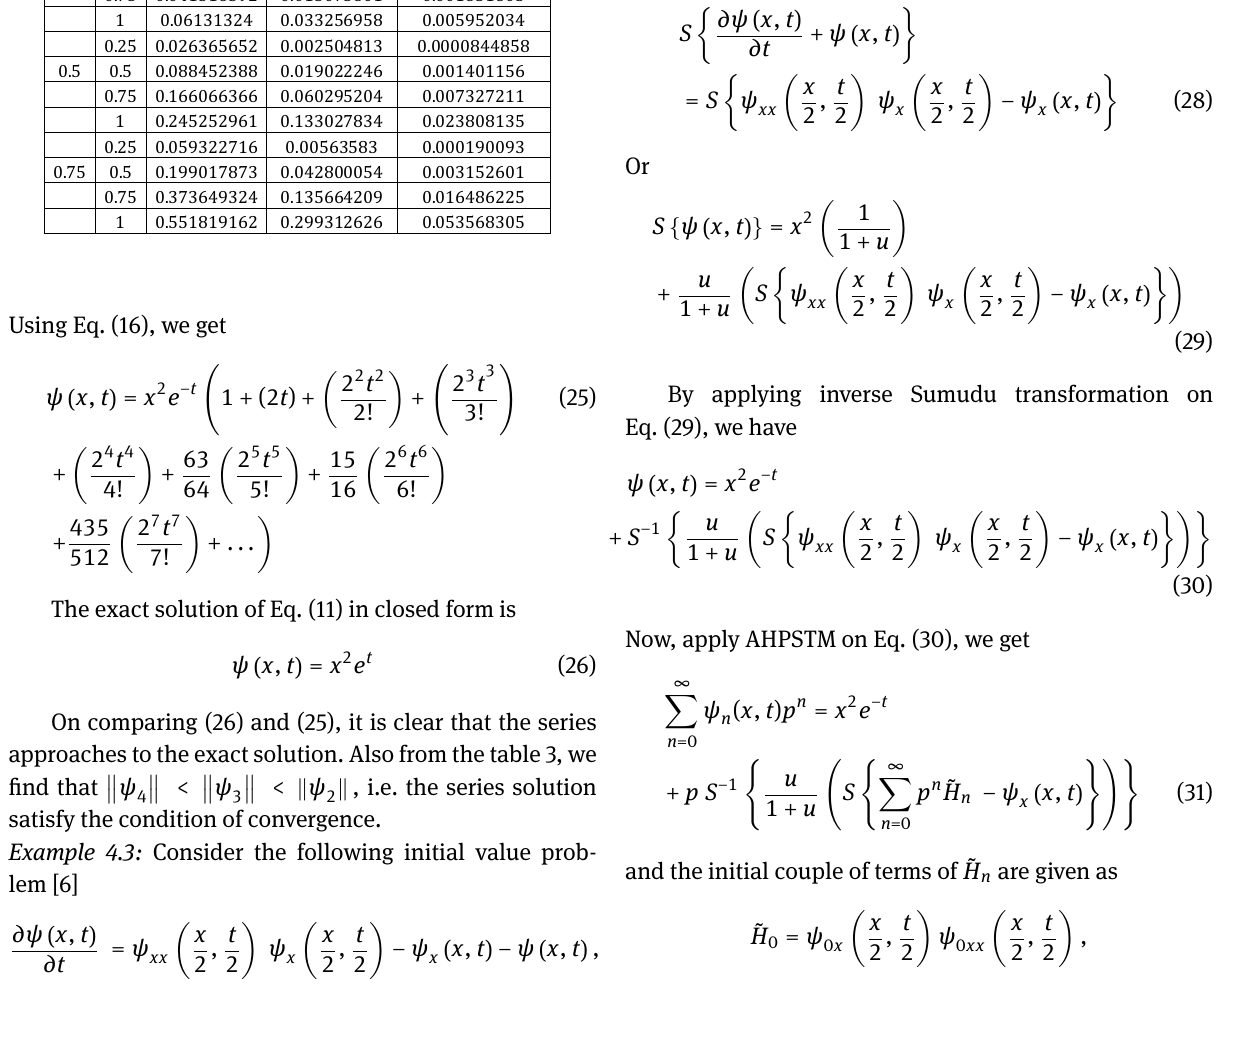
Table 3: Approximate solution of Eq.(19) using AHPSTM